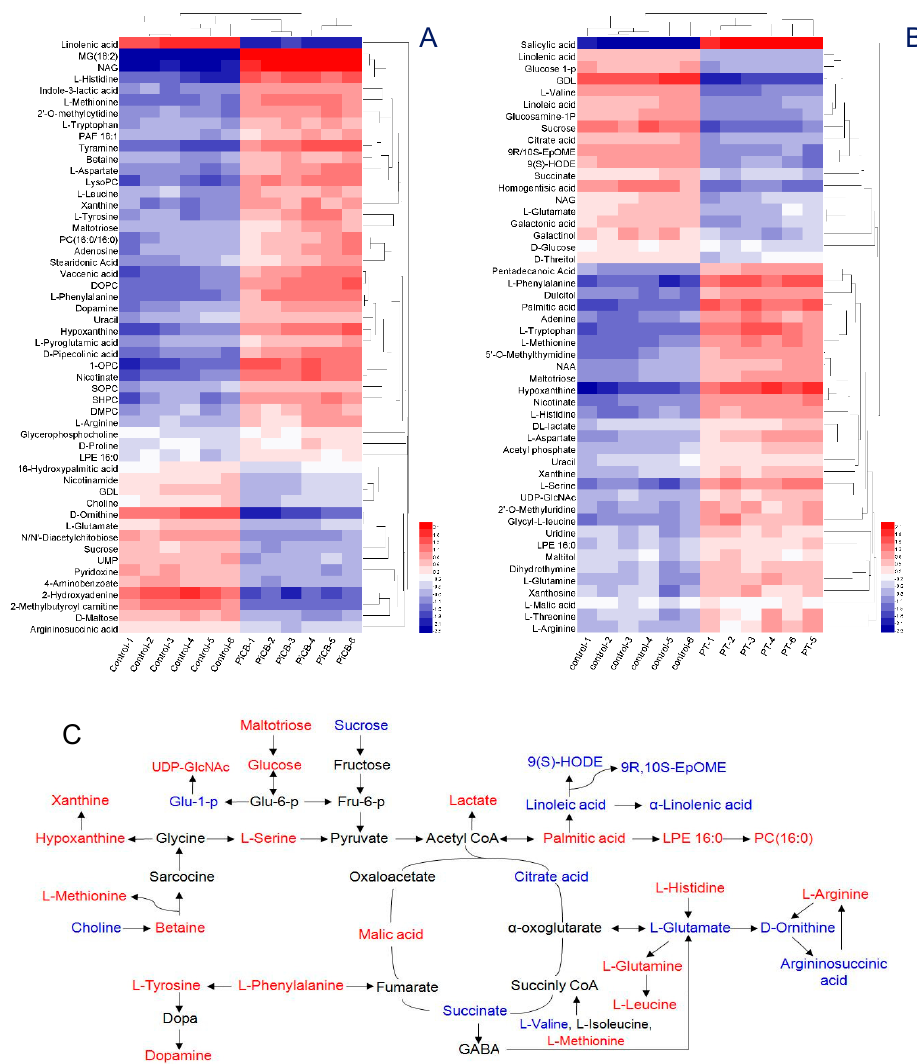
Figure 4. Heat maps of metabolites level change in the PiCB-treated and control groups. Metabolites detected by positive mode ( A ), metabolites detected by negative mode ( B ), proposed metabolism pathways of PiCB against P. digitatum ( C ). The data were converted to log base 2 ratios and then subjected to HCA with euclidean distance measures. Each rectangle in heatmap represents a metabolite and its content is colored based on a normalized scale from − 2.5 (low, blue color) to 2.5 (high, red color). Red represents increased and blue represents decreased concentrations of the metabolites ( p <